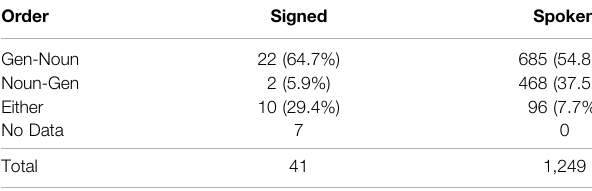
TABLE 7 | Noun/genitive order in signed and spoken